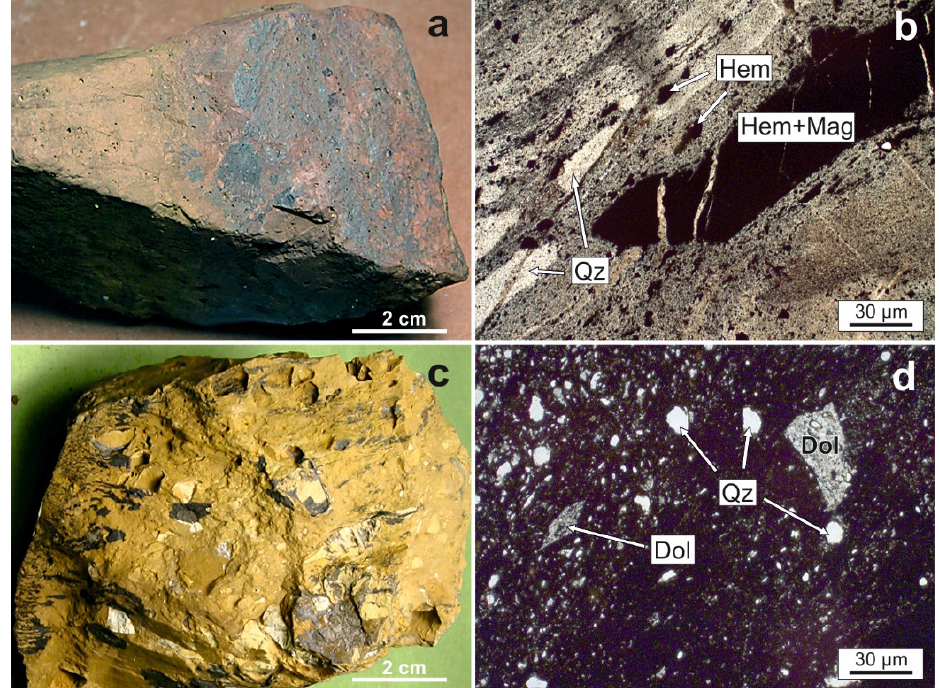
Figure 5. Hematite-rich (with magnetite) tuff ( a , b ) and breccia ( c , d ) from the Kaylan deposit. ( a , c )—hand specimens; ( b , d )—thin section microphotographs. Chemical composition of igneous rocks and samples of mineralized ore from iron- oxide deposits in the Lesser Khingan Range are listed in Table 1. Most ore samples as well as volcanic rocks have low-Ti chemical compositions with highly variable FeO, MgO and CaO contents (Table 1). Associated magmatic rocks display Table 1. Chemical composition of magnetite-hematite ores and magmatic rocks from the general sub-alkaline character, while explosive breccia samples from the Poperechnoye and Poperechnoye, Kostenga, and Kaylan deposits. Kostenga sites are characterized by elevated K 2 O contents (2.34 and 1.81 wt.%, respectively; Table 1) approaching those typical of shoshonitic volcanic series [67,68]. Ores and volcanic rocks from the Lesser Khingan are enriched in large-ion lithophile (LIL) elements (although not without significant intra-element variations mostly attributable to secondary alter- ation and metasomatism) and display well-pronounced high-field strength (HFS) element depletions indicative of their subduction origins (Figure